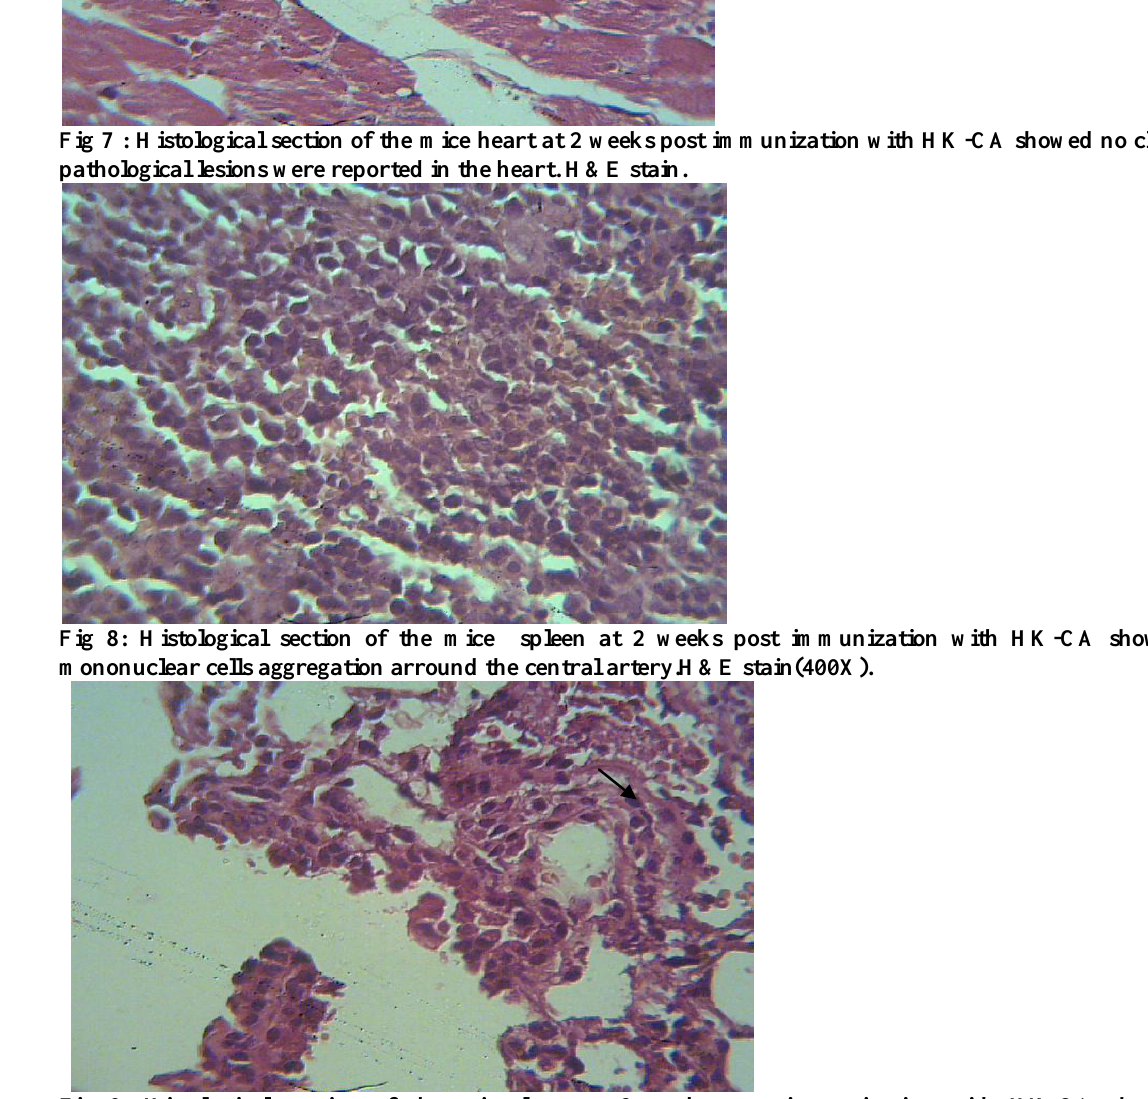
Fig 9: Histological section of the mice lung at 2 weeks post immunization with HK-CA showed mononuclear cells aggregation around blood vessel( )and interstesial tissue(*).H&E